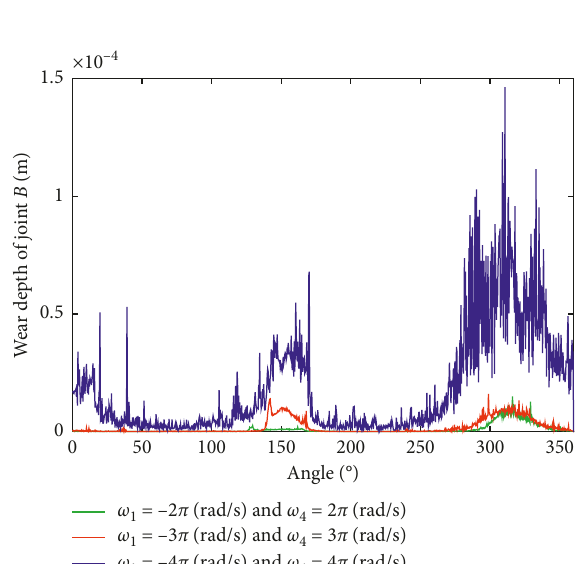
Figure 36: Wear depth at joint B .